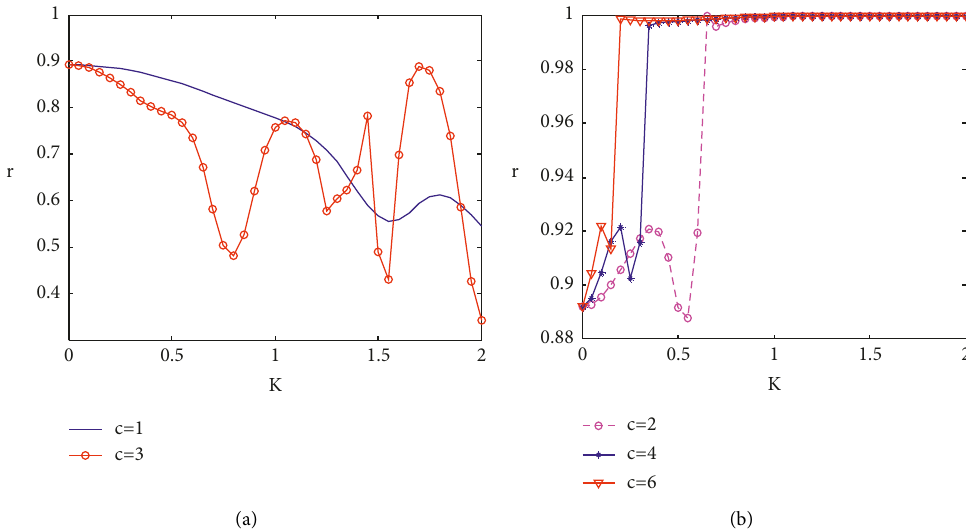
Figure 3: The evolutions of order parameters of network with different values of weight coefficients: (a) weight coefficients are odd and (b) weight coefficients are even.